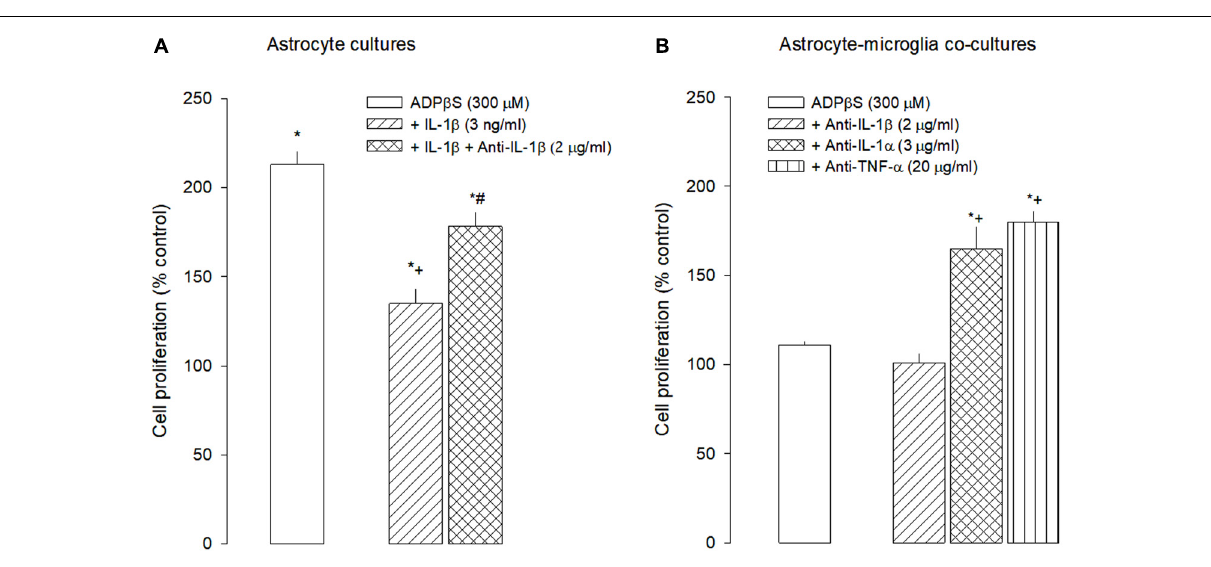
FIGURE 6 | Effect of IL-1 β and anti-IL-1 β antibody on proliferation induced by ADP β S in astrocyte cultures (A) and effect of antibodies anti-IL-1 β , anti-IL-1 α , and anti-TNF- α in proliferation induced by ADP β S on astrocyte-microglia co-cultures (B) . (A) Astrocyte cultures were incubated with ADP β S alone or in combination with IL-1 β or IL-1 β plus anti-IL-1 β antibody for 48 h. (B) Astrocyte-microglia co-cultures were incubated with ADP β S or with anti-ILs antibodies alone or with ADP β S plus anti-ILs antibodies for 48 h. Anti-ILs antibodies, when present were added at the same time as ADP β S or solvent. Methyl -[ 3 H]-thymidine (1 µ Ci/mL) was added in the last 24 h and cell proliferation was estimated by methyl -[ 3 H]-thymidine incorporation and expressed in percentage of control. Values are means ± SEM from 4 to 5 different cultures. ∗ P < 0.05, significant differences from the respective control; + P < 0.05, significant differences from ADP β S alone and # P < 0.05, significant differences from ADP β S plus the anti-IL-I1 β